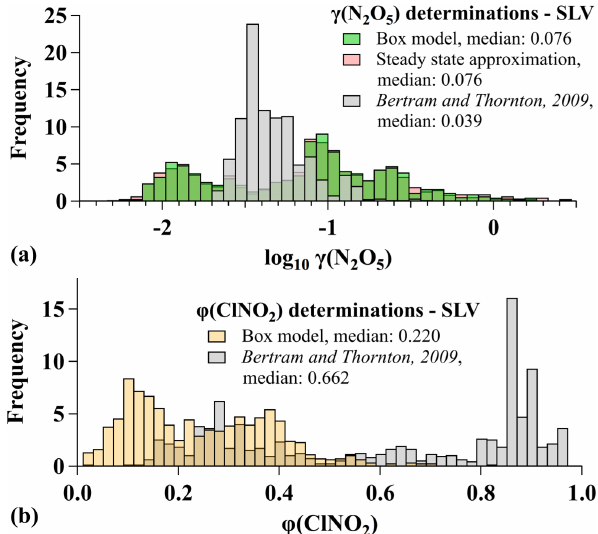
Figure 8. (a) Histograms of γ( N 2 O 5 ) determinations from the SLV during pollution events, calculated with the box model (green), steady-state approximation (pink), and parameterization from Bertram and Thornton (2009). (b) Histograms of ϕ( ClNO 2 ) determinations from the SLV during pollution events calculated with the box model (gold) and parameterization from Bertram and Thornton (2009)